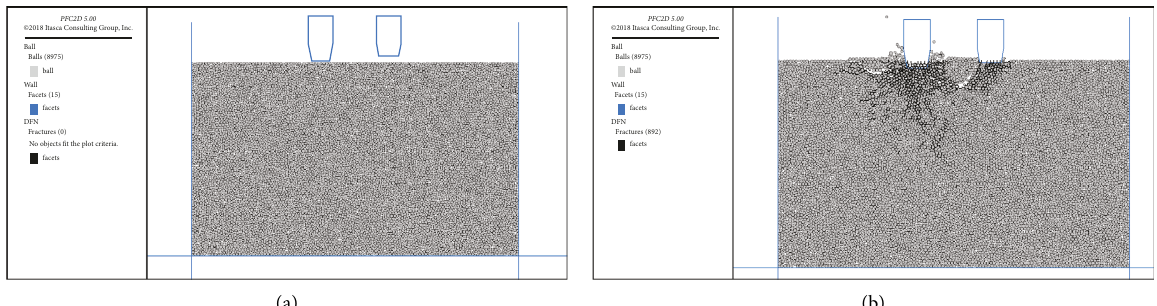
Figure 10: Rock-breaking effect of model 3: (a) before loading; (b) after loading.